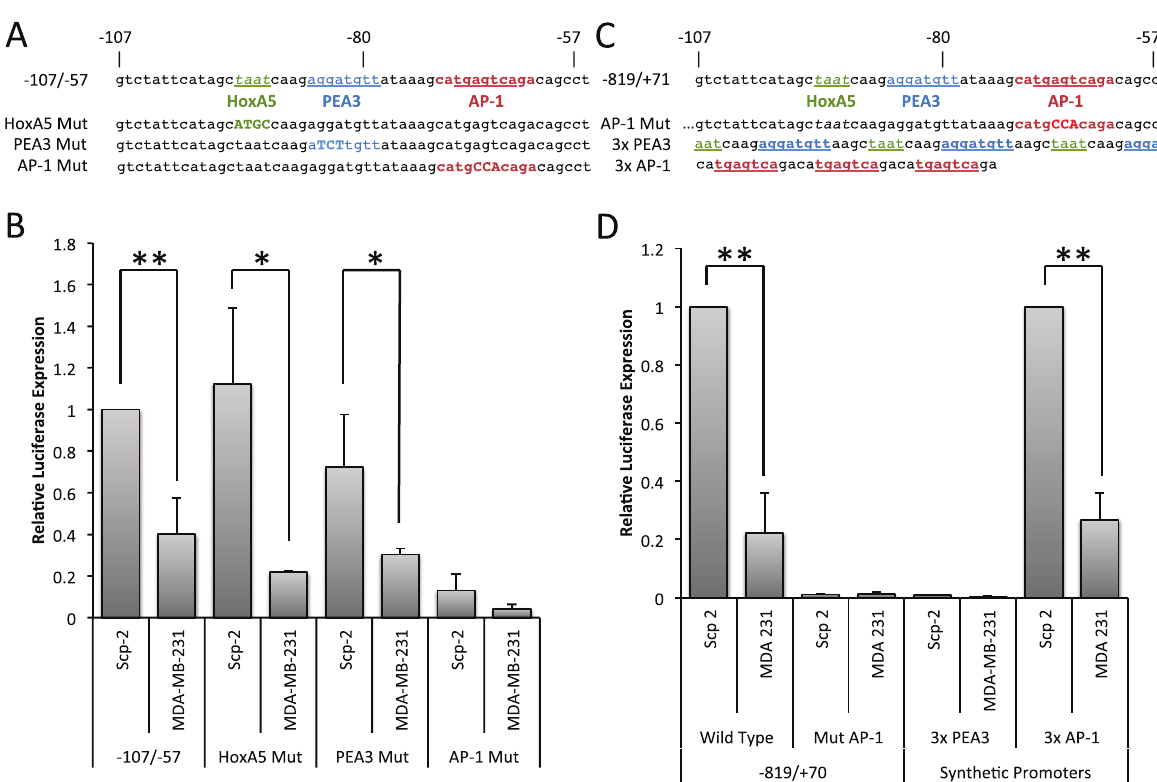
Figure 3. The AP-1 site of the MMP-1 promoter is necessary and sufficient for differential expression in Scp-2 and Scp-21 cells. A ) Sequence of MMP-1 promoter regions inserted in reporter constructs. B ) Luciferase signal from Scp-2 and MDA-MB-231 cells transfected with the indicated reporter constructs. The signal was normalized to the Renilla luciferase levels from the co-transfected pRL-SV40P plasmid. C ) Sequences of the AP1 mutation in the -819/+71 reporter and of the 3× PEA3 and AP1 inserts. D ) Luciferase signal from Scp-2 and MDA-MB-231 cells transfected with the indicated reporter constructs. The signal was normalized to the Renilla luciferase levels from the co-transfected pRL-SV40P plasmid. The 3x AP-1 construct values were normalized to 1.0 for the Scp-2 cells. Its expression was approximately three times stronger than the -819/+71 MMP-1 luciferase reporter. The data shown represent mean +/- standard deviation from three independent experiments. *, p < 0.05 ; **, p < 0.005 for two-tailed